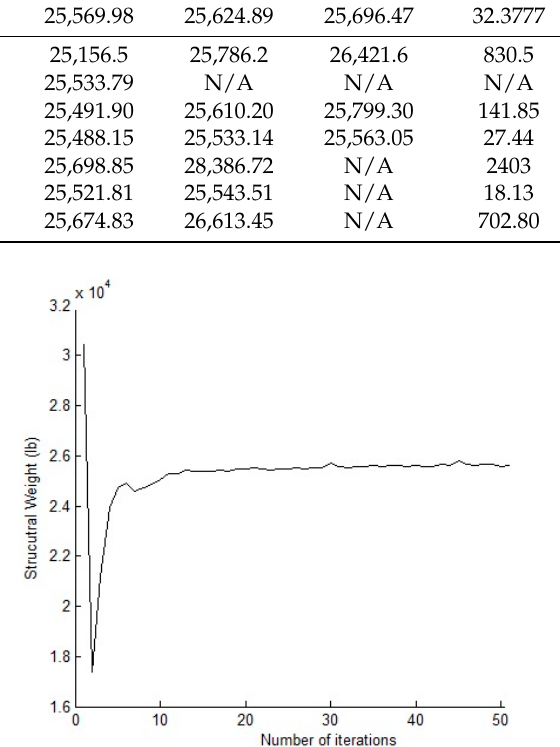
Table 11. Comparison of statistical performance in the 200-bar truss problem.